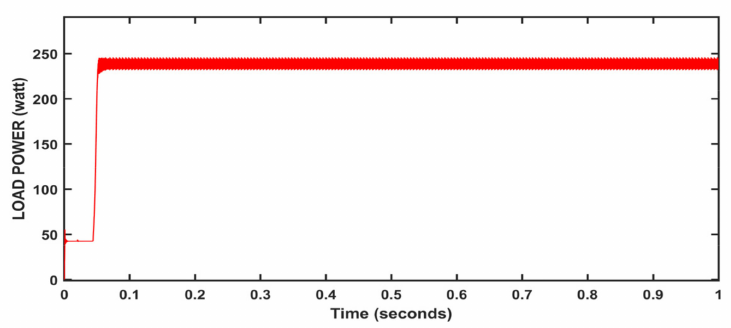
Figure 22. Output power of FLC system at constant load, temperature, and